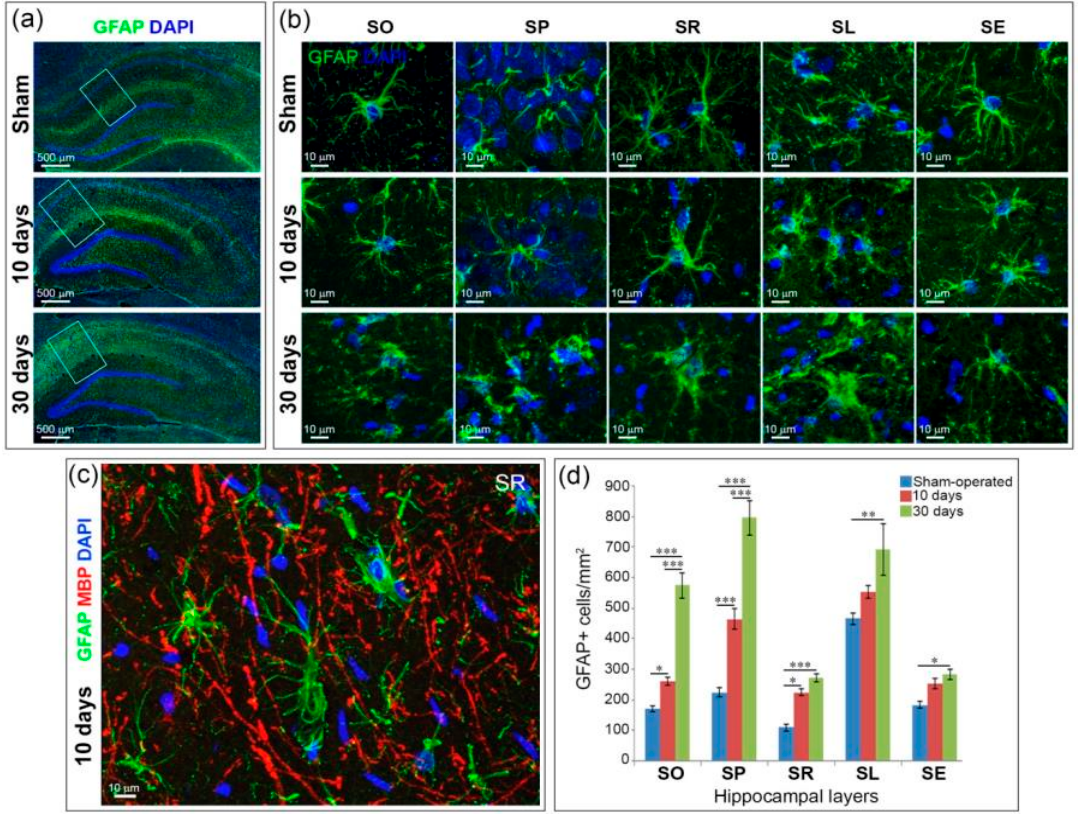
Figure 3. Astrogliosis and astrocyte morphology (GFAP+cells) after GCI. ( a ) General views of the hippocampus in sham-operated animals and 10 and 30 days after GCI. The white rectangles show the areas within which cells with morphology characteristic of each layer were selected, 20× objective; ( b ) representative views of the morphology of GFAP-positive cells in hippocampal layers. Images taken from a series of optical slices using software MIP; ( c ) An example of radial orientation of astrocyte processes in the SR. A 40× oil immersion objective was used to obtain ( b ) and ( c ) images; ( d ) quantification of GFAP-positive astrocytes in the hippocampal layers in the sham-operated and postischemic animals, at day 10 and 30 after GCI. Significant di ff erences between the groups, according to ANOVA after LSD correction for multiple comparisons: ***— p < 0.001; **— p < 0.01; *— p <